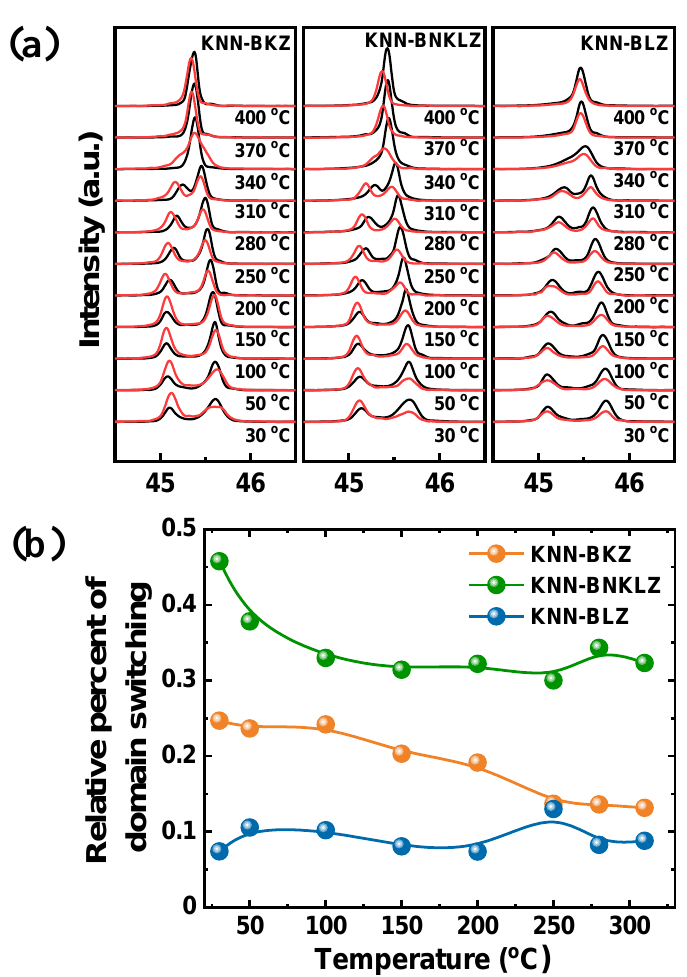
Figure 4. ( a ) High-temperature XRD patterns, which were measured in situ at each elevated temperature for unpoled (black line) and poled (red line) KNN-BMZ ceramic samples and ( b ) relative percentage of domain switching η 002 (extrinsic contribution), which was obtained from variation of the integrated areas of the (002) and (200) peaks.